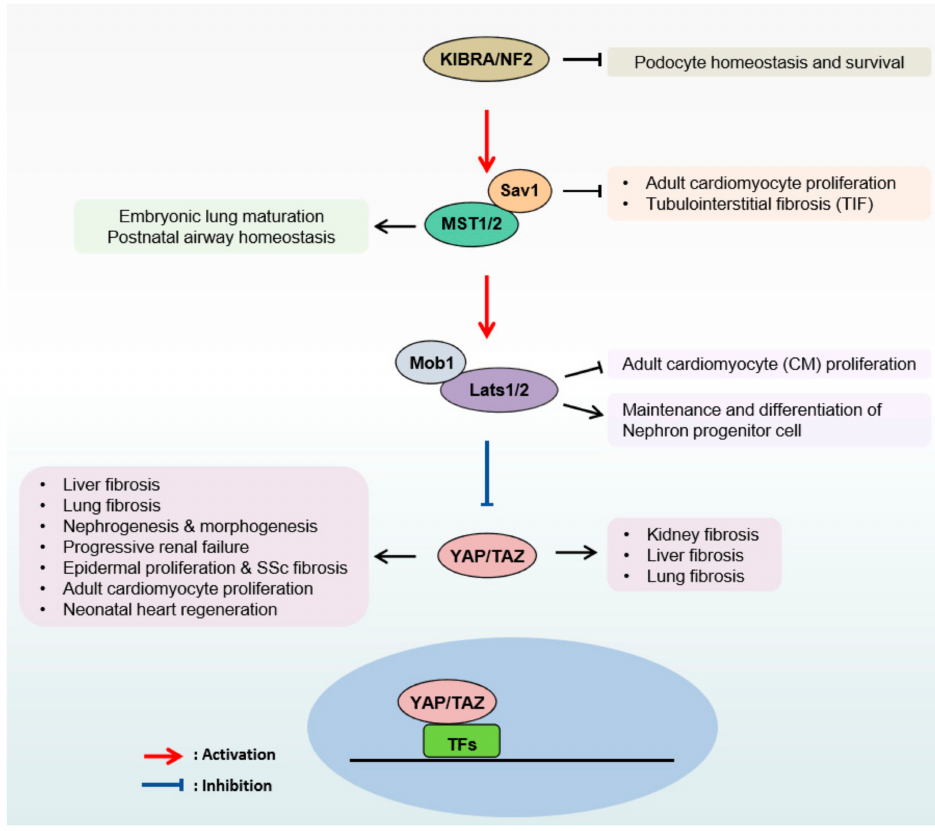
Figure 2. The Hippo pathway drives fibrosis across the